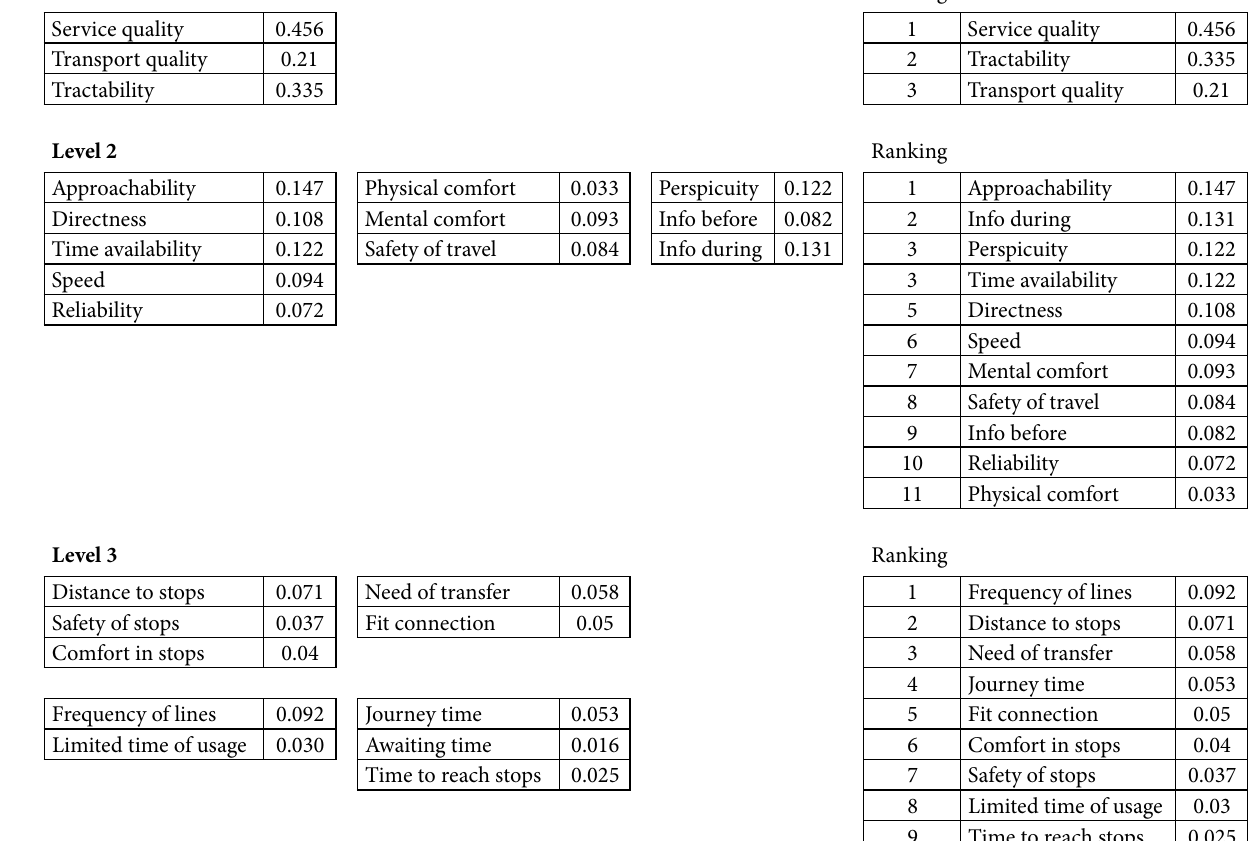
Table 1. Results of the AHP phase (source: research by